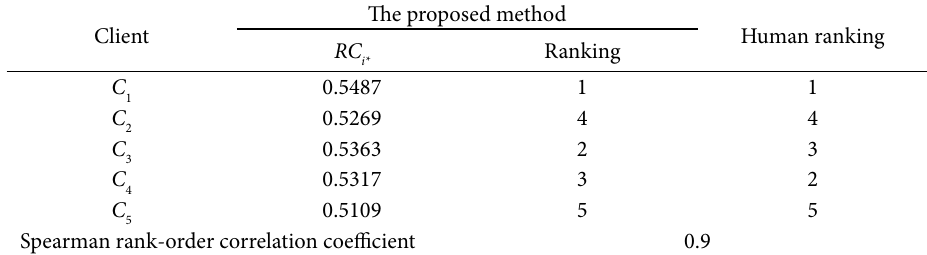
Table 7. Comparison of results between the proposed method and manual ranking for DM1 The proposed Client